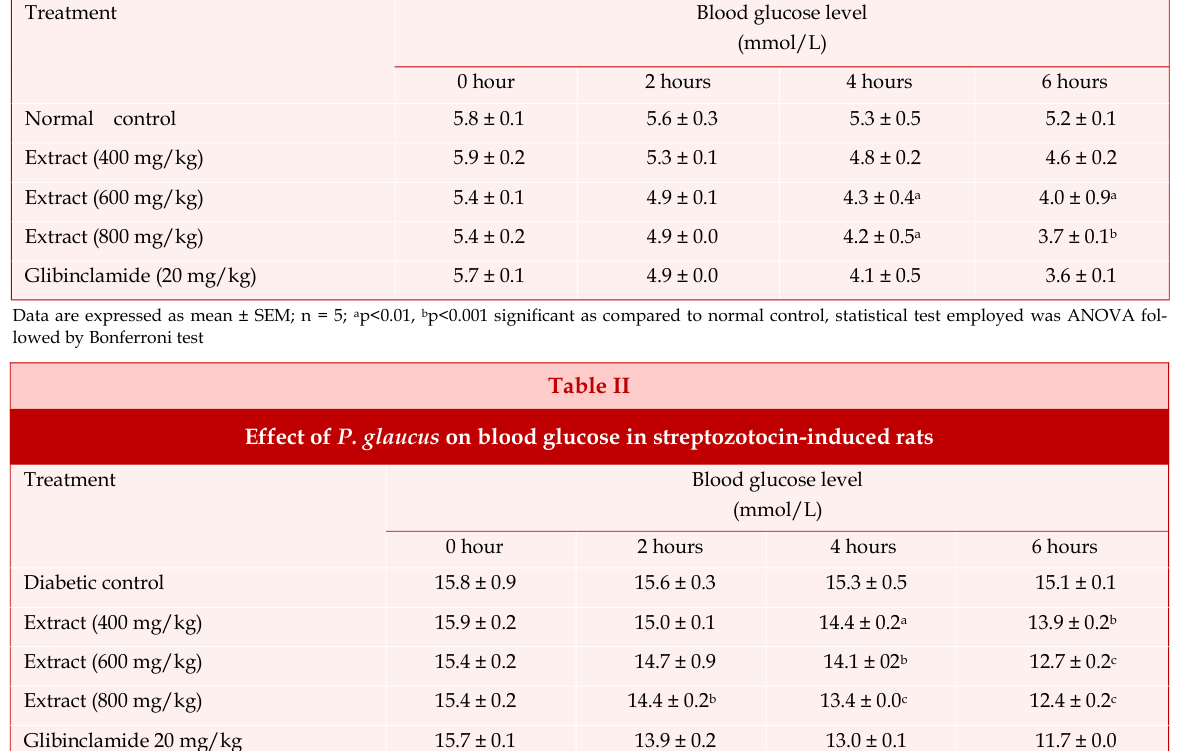
Effect of P. glaucus on blood glucose level in normal rats